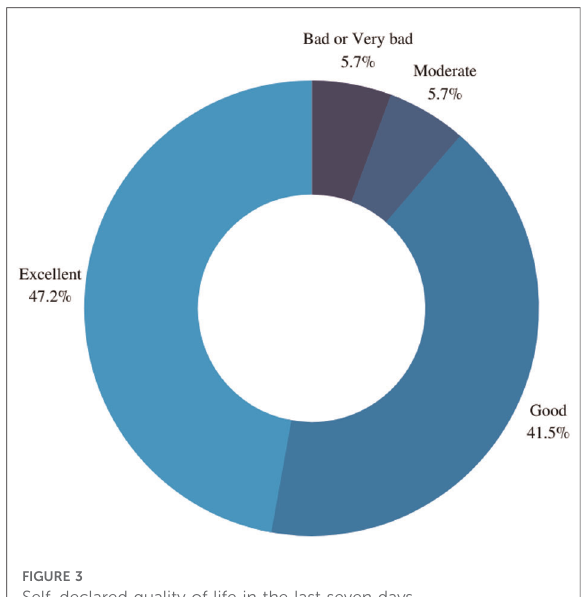
FIGURE 3 Self-declared quality of life in the last seven days.